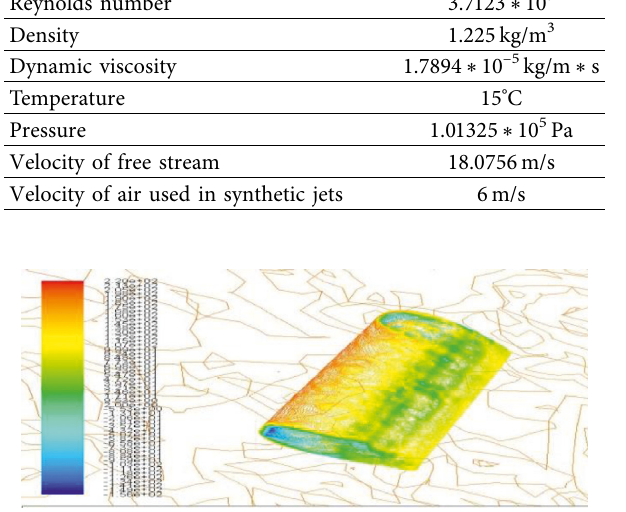
Figure 8: Total pressure at 0 ° AOA for the 1st